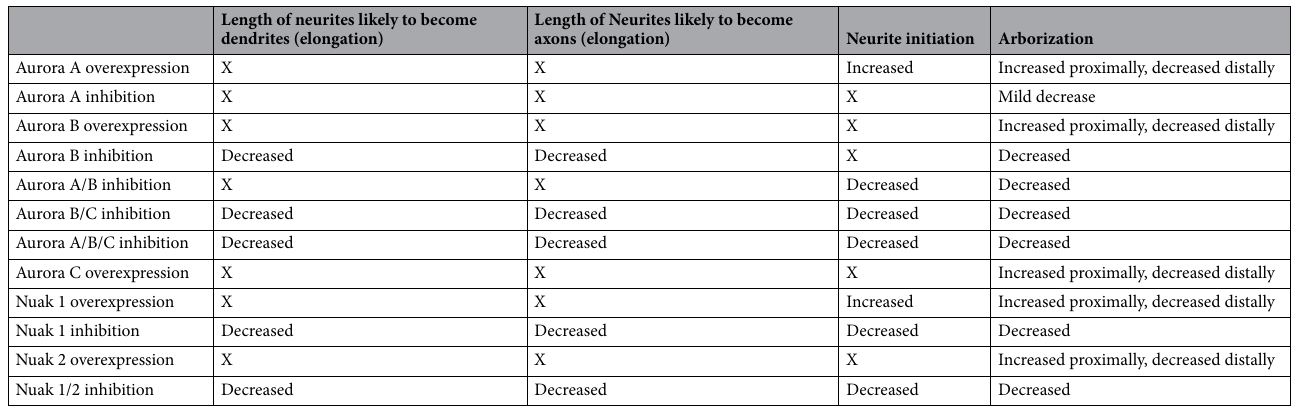
Table 4. Summary table of the phenotypes observed in primary cortical neurons when each Aurora and Nuak kinase was either overexpressed or inhibited. X = no significant